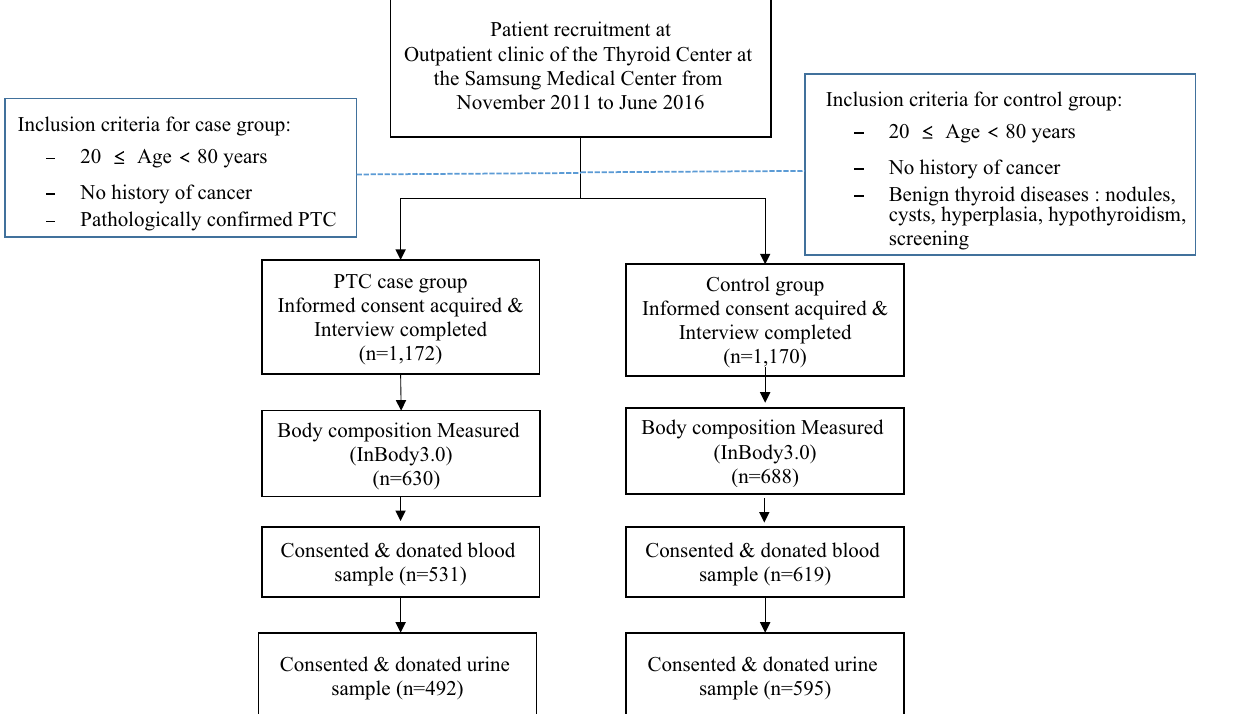
Figure 1. Recruitment of case–control study participants and study flow